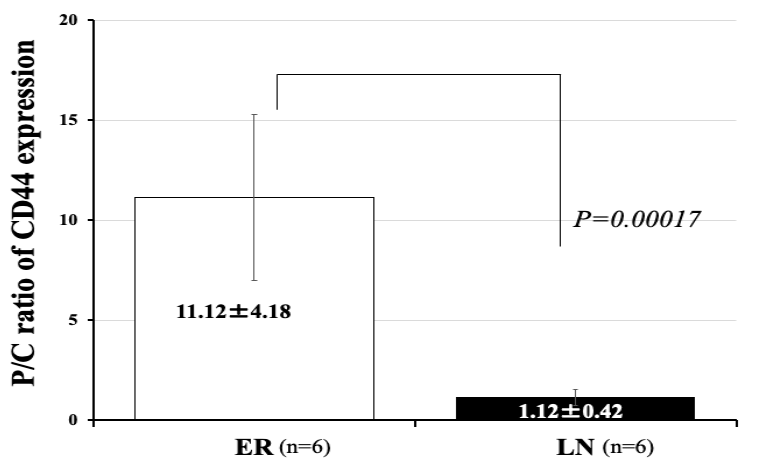
Figure 4. Expression of mRNA of CD44 in 12 patients with GBM. Periphery/core (P/C) ratios for CD44 expression in the ER group (high invasive) and LN group (low invasive). The ER group (high invasive) showed a significantly higher P/C ratio for CD44 than the LN group (low invasive) (ER vs. LN: 11.12 ± 4.18 vs. 1.12 ± 0.42) ( p = 0.00017). The bar graph shown in a white color represent CD44 expression of ER and that in a black color represent CD44 expression of LN. Error bars represent standard deviation.